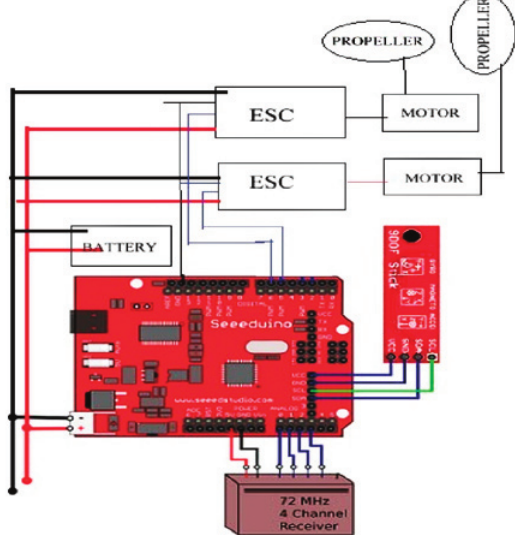
Fig. 3. Arduino connections with the other important